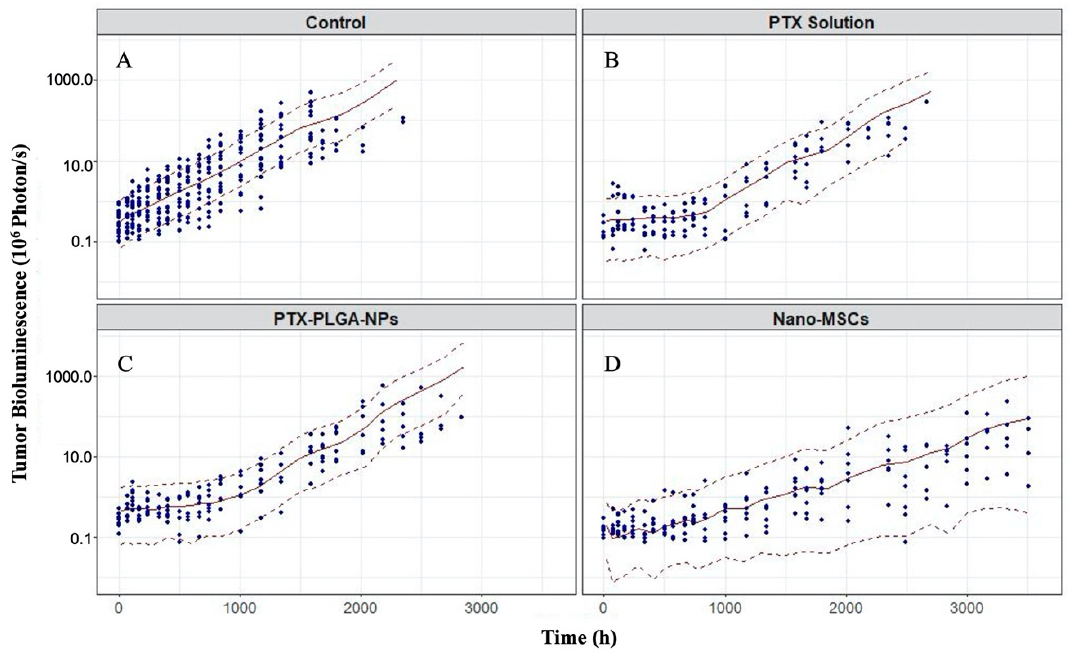
Figure 6. Prediction-corrected visual predictive check (pcVPC) for tumor bioluminescence–time profiles in animals receiving no treatment ( A ), PTX solution ( B ), PTX-PLGA NPs ( C ) and nano-MSCs ( D ). The plots are on log scales. The dots represent observations. The red solid lines are the median of model-predicted tumor bioluminescence profile. The red dashed lines are 10th and 90th percentiles of model-predicted tumor bioluminescence profiles, respectively.